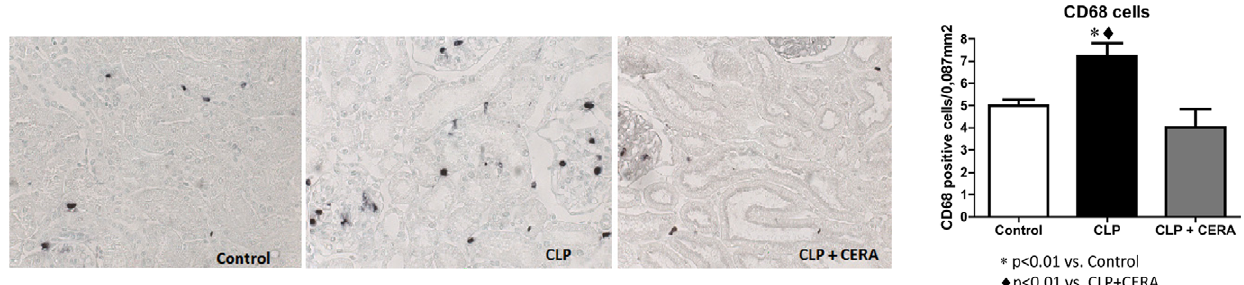
Figure 6. Number of CD68-positive cells/0.087 mm 2 field in the tubulointerstitium at 24 h after CLP. A , photomicrographs of immunohistochemical staining in control rats, rats submitted to cecal ligation and puncture only, and rats treated with continuous erythropoietin receptor activator prior to undergoing cecal ligation and puncture (magnification, 6 40). B , Graphic representation of CD68-positive cell counts. Data are mean 6 SEM. p . 0.05 for control vs. CLP + CERA. CLP, cecal ligation and puncture; CERA, continuous erythropoietin receptor